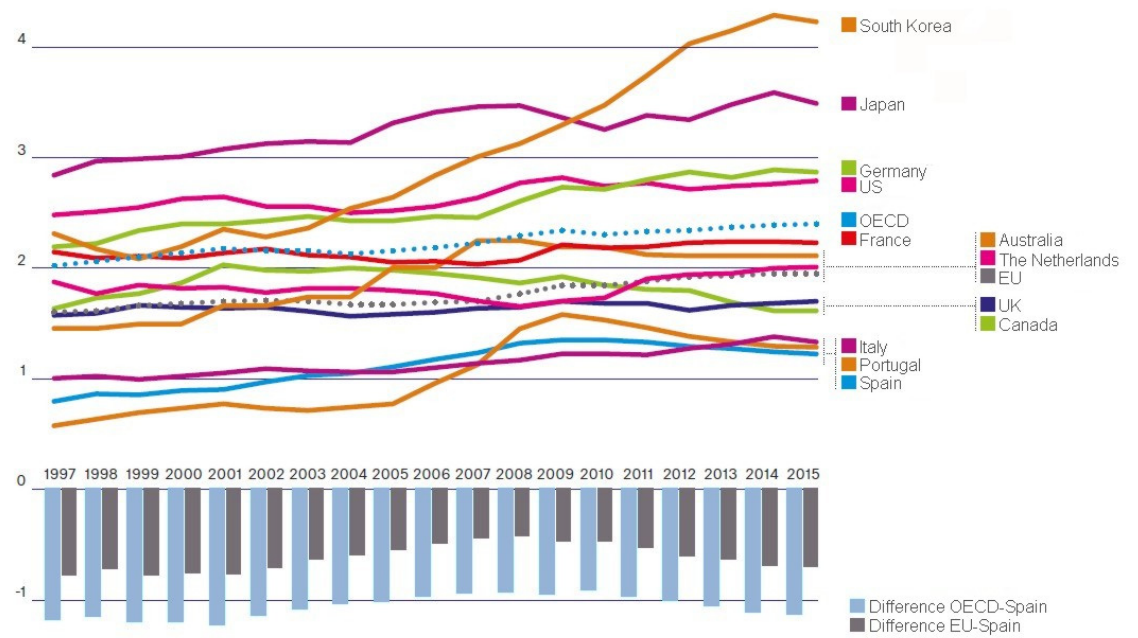
Figure 9. Evolution of Spain’s R&D expenditure as a percentage of gross domestic product compared to other countries. Source: OECD; Sanz and Cruz, 2017.